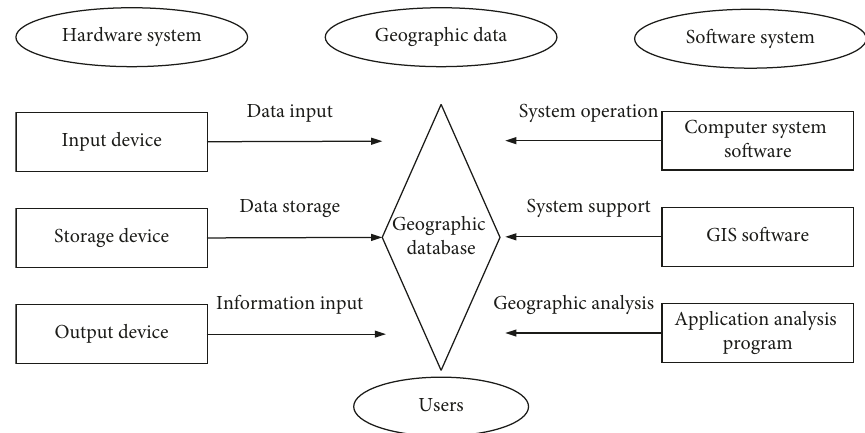
Figure 3: Composition of GIS